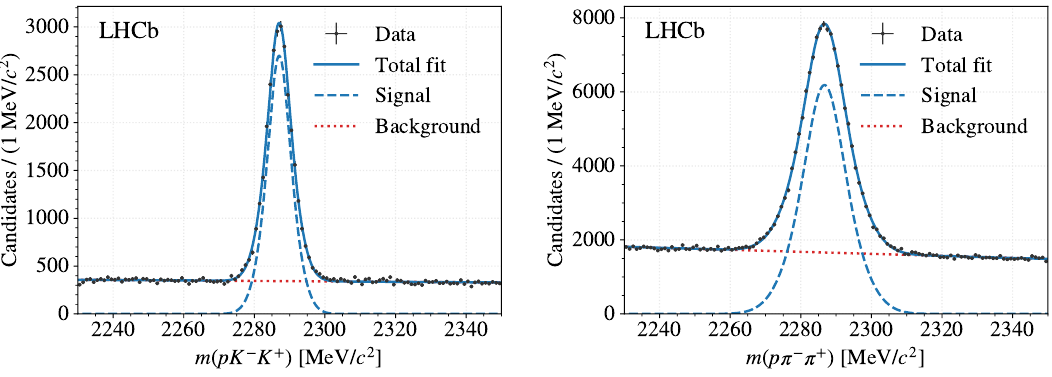
! pK (cid:0) K + (left) and c ! p(cid:25) (cid:0) (cid:25) + mode results in a c